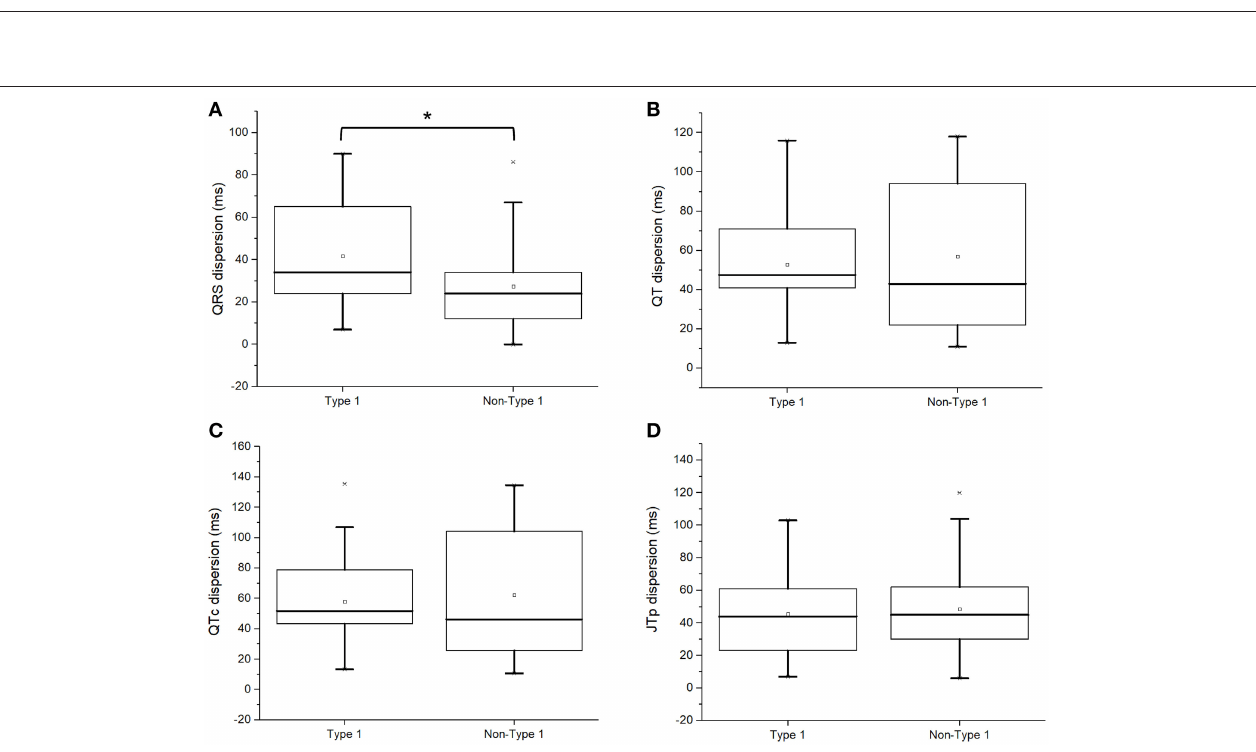
FIGURE 3 | QRS dispersion (A) , uncorrected QT dispersion (B) , corrected QT dispersion (C) , or JT peak dispersion (D) in type 1 and non-type 1 Brugada syndrome patients. *Denotes significant difference between the two groups.